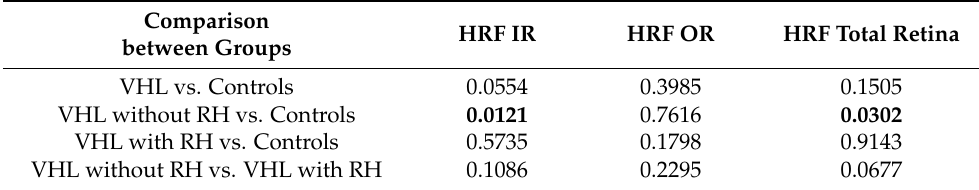
Table 11. Statistical significance ( p -value) of HRF in internal, external and total retina in the analyzed groups. Comparison